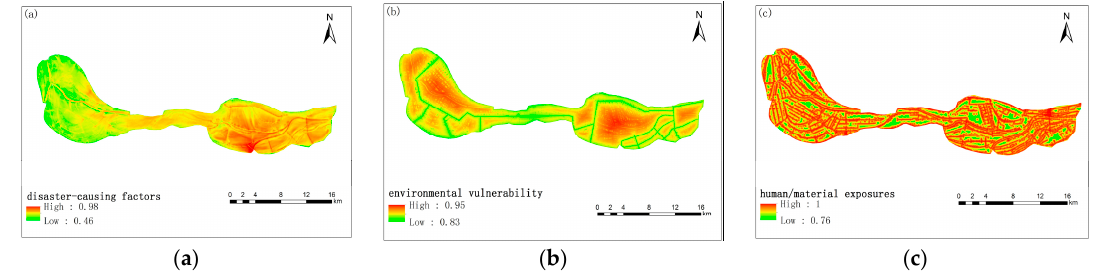
Figure 12. Swallowtail catastrophe calculation map for the comprehensive flood hazard risk (FHR). ( a ) disaster-causing factors, ( b ) environmental vulnerability and ( c ) human / material